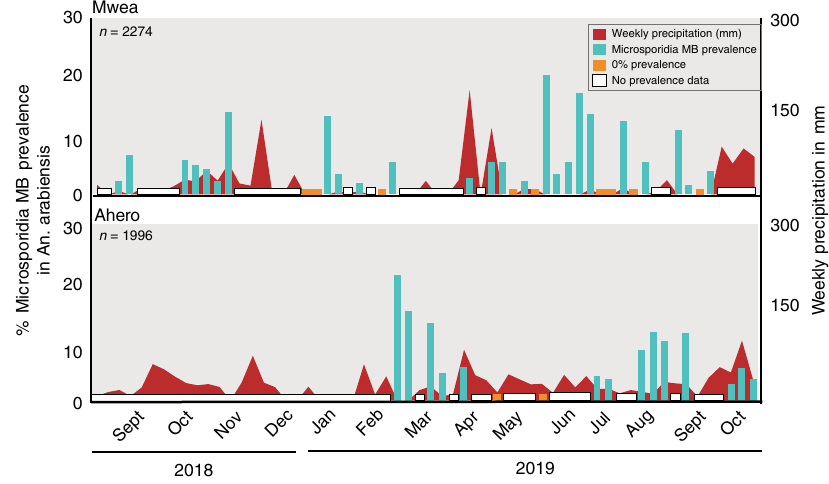
Fig. 2 Seasonal variation in Microsporidia MB prevalence in two sampling sites. Weekly precipitation values given are based on earth observation and are shown in dark blue. Light blue bars indicate the prevalence of Microsporidia MB , monitored in weekly collections. Overall, 136 out of 2274 (6%) female An. arabiensis were found to be infected with Microsporidia MB in Mwea and 159 out of 1996 (8%) female An. arabiensis in Ahero. Source data are provided as a Source Data fi